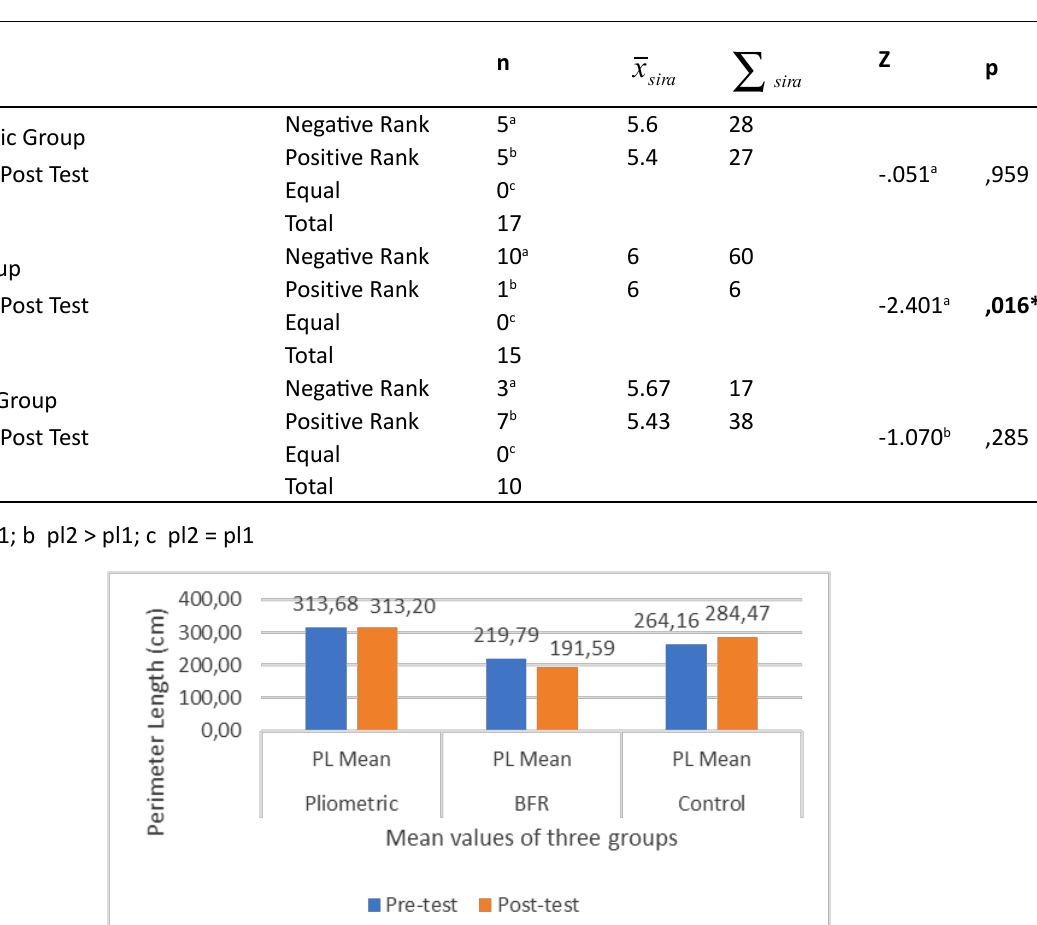
Table 3. Dynamic Balance According to Training Groups